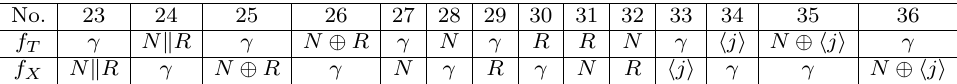
Table 1: Trivially insecure GCTR